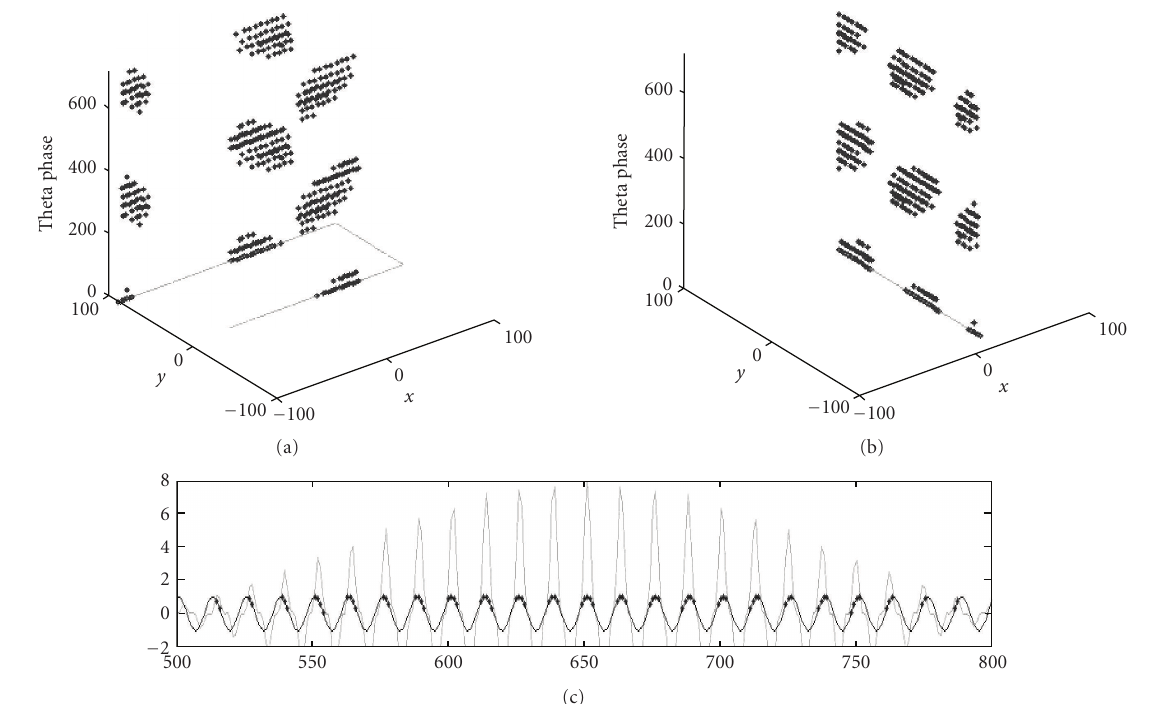
Figure 4: Simulation of theta phase precession in grid cell model based on membrane potential oscillations. (a) Theta phase plotted on vertical axis as a simulated rat runs through a grid cell firing field in west to east and east to west directions. (b) Theta phase during run from south to north. (c) Spike times (filled circles) of summed oscillations in a neuron relative to oscillation in the soma of that neuron (negative of network theta